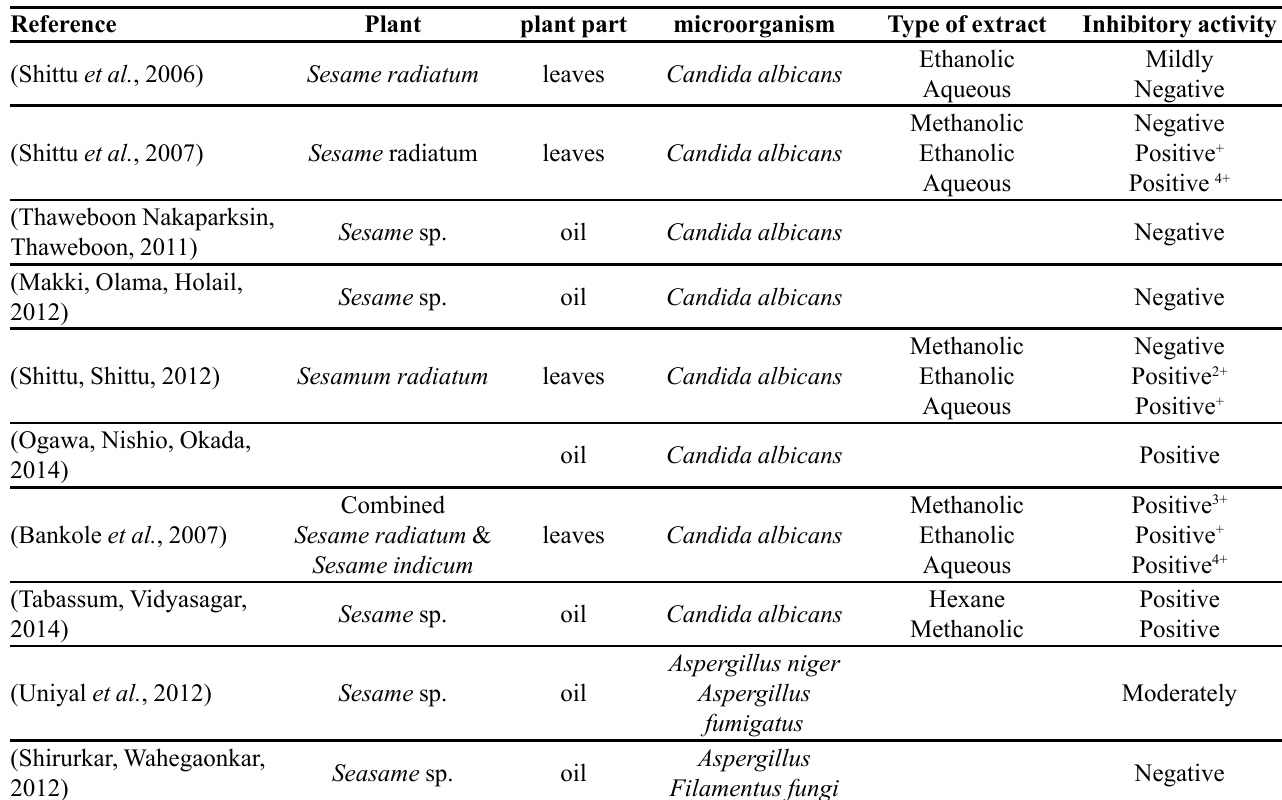
TABLE III - The comparative antifungal activity of different parts and extracts of sesame seed